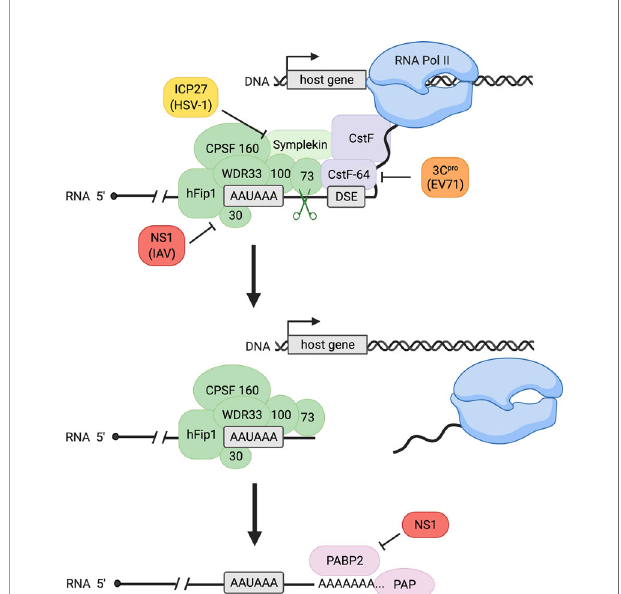
FIGURE 1 | Canonical host 3´-end processing is a multi-step process with multiple opportunities for interference by viral proteins. RNA 3´-end processing begins with endonucleolytic cleavage of the nascent transcript by cleavage and polyadenylation speci fi city factor (CPSF, shown in green), composed of CPSF30, CPSF73, CPSF100, CPSF160, WDR33, and hFip1, and auxiliary factors including cleavage stimulation factor (CstF, a four-subunit factor shown in purple with only its CstF-64 subunit speci fi ed) and symplekin. The CPSF complex recognizes the polyadenylation signal (PAS, most common sequence AAUAAA as shown) on the transcript, and the catalytic subunit CPSF73 cleaves at a site downstream of the PAS, facilitated by CstF binding to the downstream sequence element (DSE). Following cleavage, transcription terminates, releasing the nascent RNA and RNA polymerase II (Pol II) from the DNA. Polyadenylation of the cleaved transcript is catalyzed by poly(A) polymerase (PAP) and supported by poly(A) binding protein II (PABP2). During viral infection, in fl uenza A virus (IAV) protein NS1 binds CPSF30, preventing CPSF-RNA binding, whereas herpes simplex virus-1 (HSV-1) protein ICP27 inhibits proper assembly of the CPSF complex. Enterovirus 71 (EV71) 3C protease (3C pro ) cleaves CstF-64, decreasing RNA 3´-end processing ef fi ciency. In fl uenza NS1 also binds PABP2, inhibiting the synthesis of long poly(A)